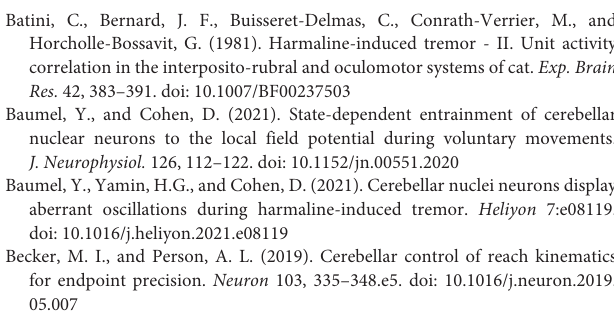
Supplementary Figure 1 | Changes in tremor amplitude over time. Mean accelerometer amplitude spectrum for one rat at different time points following systemic administration of harmaline (10 mg/kg,